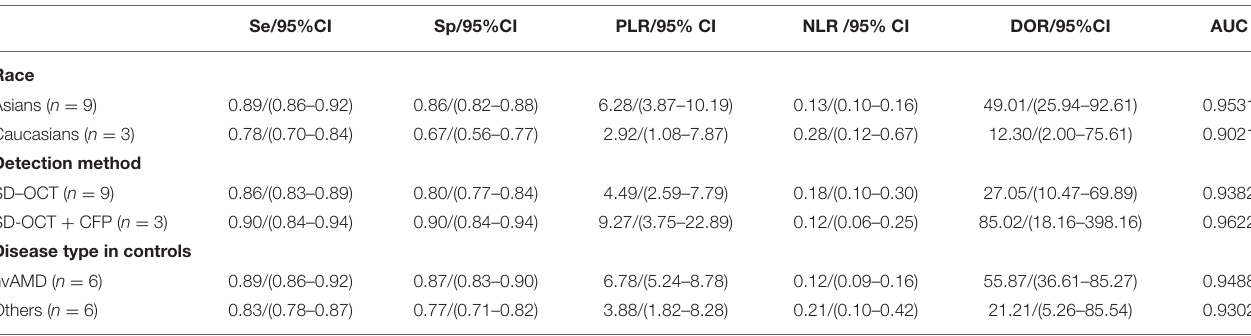
TABLE 3 | Parameters of subgroup